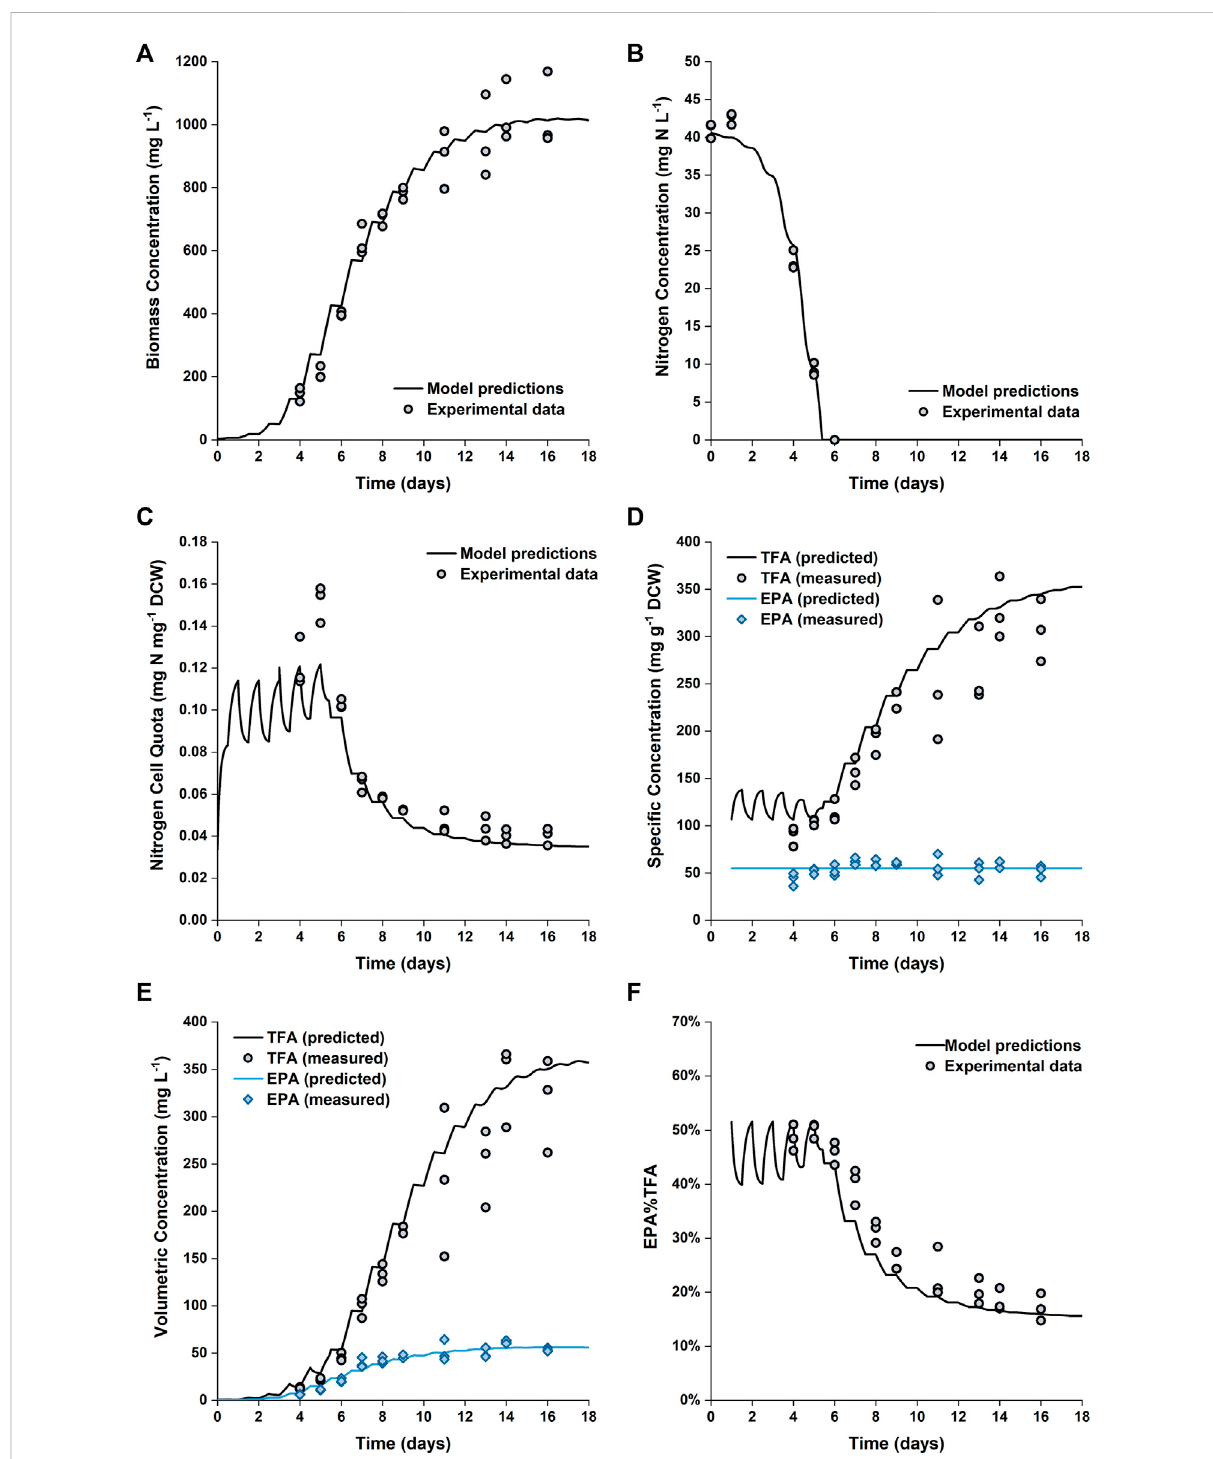
FIGURE 6 Comparison between experimentally measured and predicted biomass concentration (A) , nitrogen concentration in the growth medium (B) , intracellular nitrogen cell quota (C) , spec fi c concentrations of total fatty acids and EPA in biomass (D) , volumetric concentrations of total fatty acids and EPA (E) and EPA fraction in total fatty acids (F) of P. tricornutum grown in batch cultures in 5 L fl at-panel PBRs. Experiments were performed in triplicate with all data points being